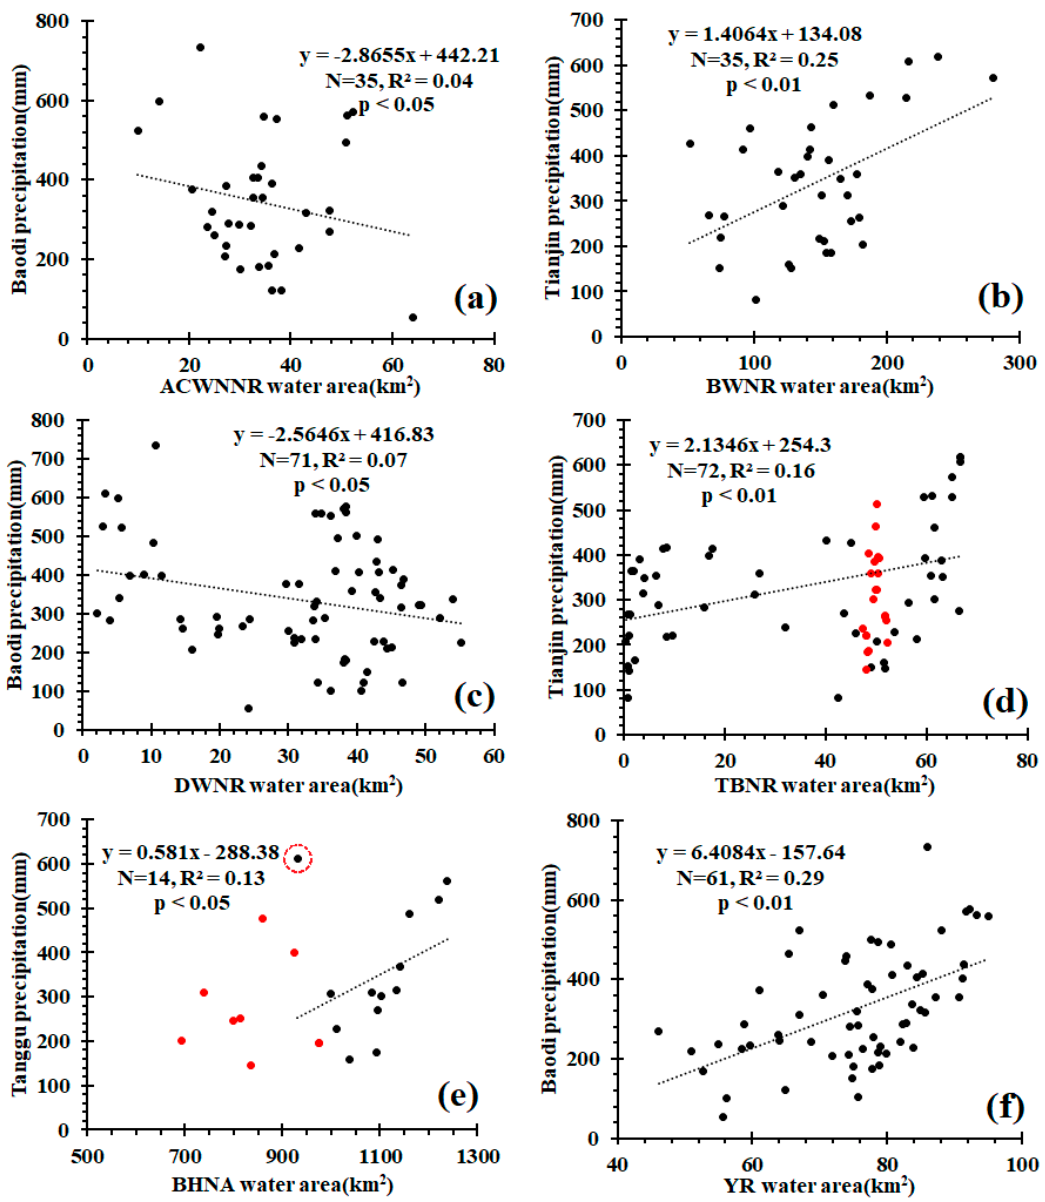
Figure 7. Relationship between the water area of the six study sites and accumulated precipitation of three months before the image acquisition dates in the nearest meteorological station. The red dots data were collected after the land reclamation and were not considered when calculated the regression functions. ( a ) Relationship between ACWNNR water area and precipitation of Baodi meteorological station, ( b ) Relationship between BWNR water area and precipitation of Tianjin meteorological station, ( c ) Relationship between DWNR water area and precipitation of Baodi meteorological station, ( d ) Relationship between TBNR water area and precipitation of Tianjin meteorological station, ( e ) Relationship between BHNA water area and precipitation of Tanggu meteorological station, ( f ) Relationship between YR water area and precipitation of Baodi meteorological station.